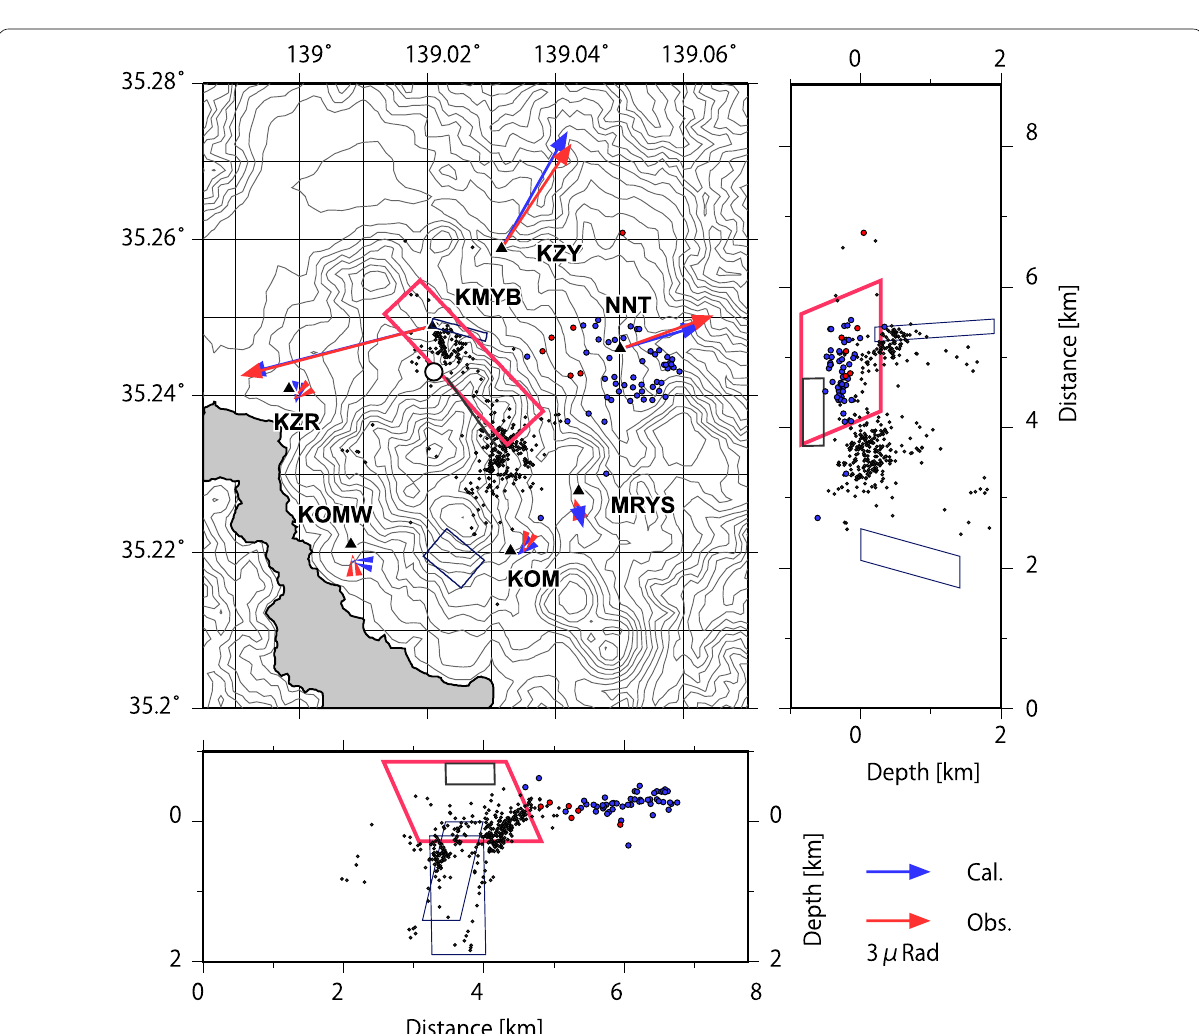
Fig. 6 Comparison of the observed (red arrows) and calculated (blue arrows) tilt changes. The open crack model used to calculate tilt changes is indicated by red rectangles. The blue rectangles show the open cracks determined from the tilt changes observed during the 2001 unrest (Daita et al. 2009). A nearly vertical open crack at a shallow depth that was obtained from InSAR data is indicated by small black rectangles (Doke et al. 2018). The eruption center is illustrated by a white circle. Black dots are earthquakes that occurred at 7:00 a.m.–12:00 p.m. on June 29, 2015. Blue and red circles are hot spring wells. Hot springs represented by red circles are chemically close to hydrothermal water from magma body at deeper